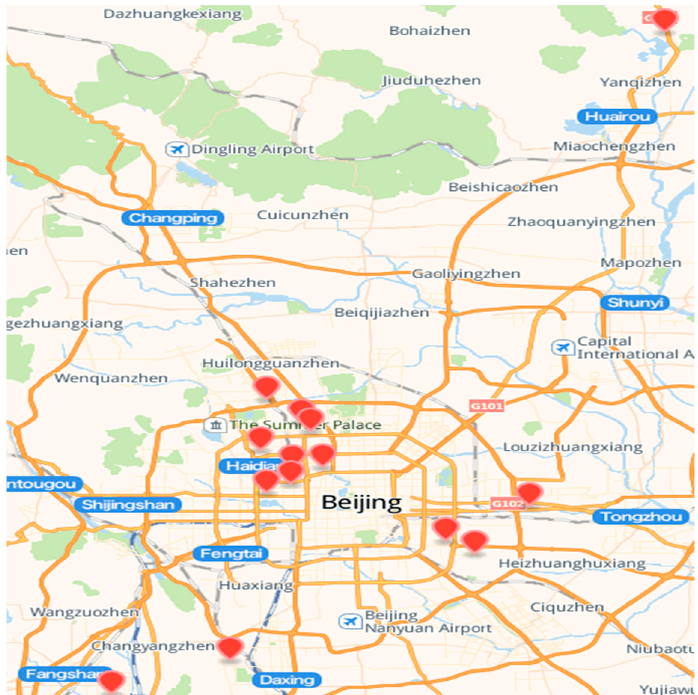
Figure 1. Sampling